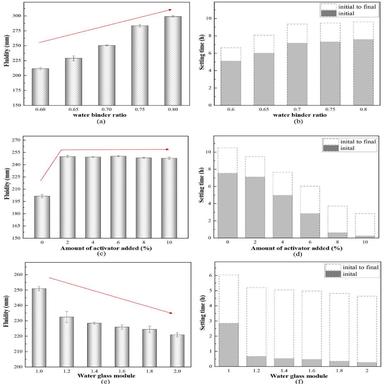
Effect of raw material ratio on fluidity and setting time of grouting materials (a-b:The activator ratio is 2%, the water glass modulus is 1.0, and the water binder ratio is 0.6–0.8. c-d:The ratio of activator is 0–10%, the modulus of sodium silicate is 1.0, and the water binder ratio is 0.7. e–f: the ratio of activator is 6%, the modulus of sodium silicate is 1.0–2.0, and the water binder ratio is 0.7).